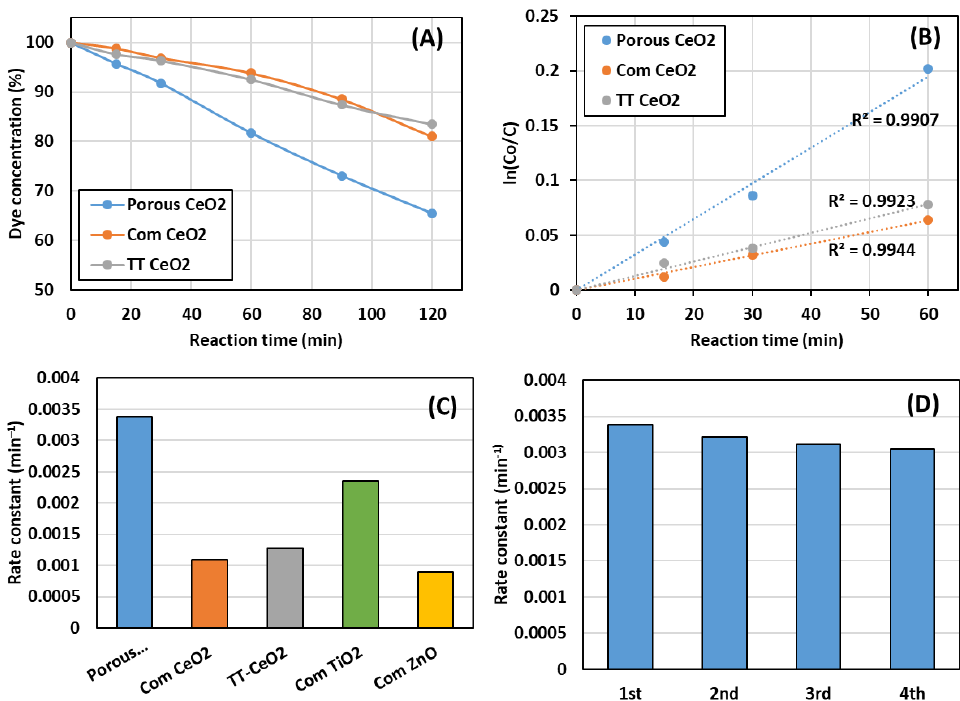
Figure 6. The obtained photocatalytic data for the decolorization reaction of methyl green dye under the illumination of visible light: ( A ) the decolorization profiles, ( B ) the first-order kinetic profiles, ( C ) the first-order rate constants for samples, and ( D ) the reusability of porous ceria sample in consecutive four runs.